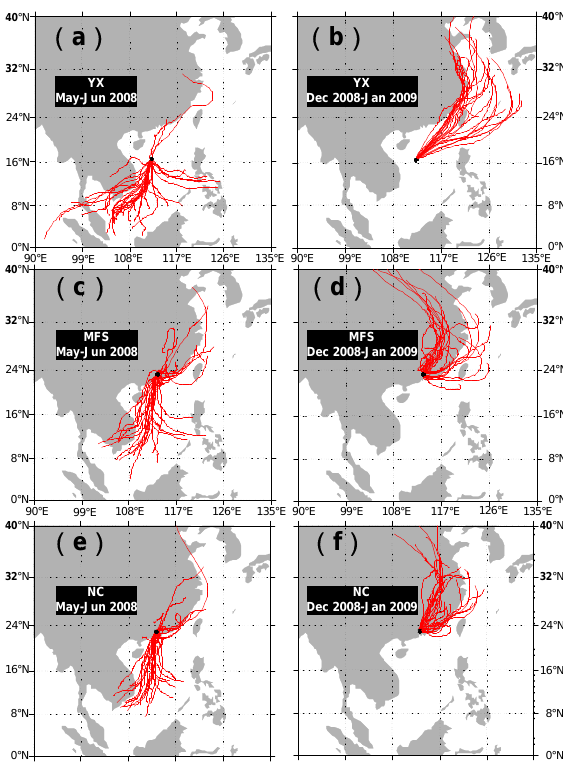
Figure 3 . The back trajectories (72h) of the air masses arriving at Yongxing Island and the Fig. 3. The back trajectories (72h) of the air masses arriving at Pearl River Delta at 8:00 am local time on each day. (a) Yongxing (YX) island (150 m ASL) Yongxing Island and the Pearl River delta at 08:00 a.m. (LT) on each from May 16 2008 to June 20 2008; (b) Yongxing (YX) Island (150 m ASL) from December 12 2008 to January 8 2009; (c) Maofengshan (MFS) (535 m ASL) from May 16 2008 to June 20 2008; (d) day. (a) Yongxing (YX) island (150ma.s.l) from 16 May to 20 June Maofengshan (MFS) (535 m ASL) from December 12 2008 to January 8 2009; (e) Nancun (NC) (150 2008; (b) Yongxing (YX) Island (150ma.s.l.) from 12 December m ASL) from May 16 2008 to June 20 2008; (f) Nancun (NC) (150 m ASL) from December 12 2008 to January 8 2009.